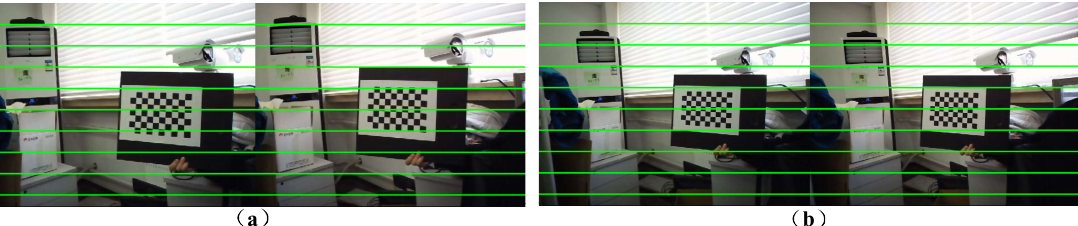
Figure 5. Checkerboard before and after stereo correction processing: ( a ) Before stereo correction; ( b ) After stereo correction.